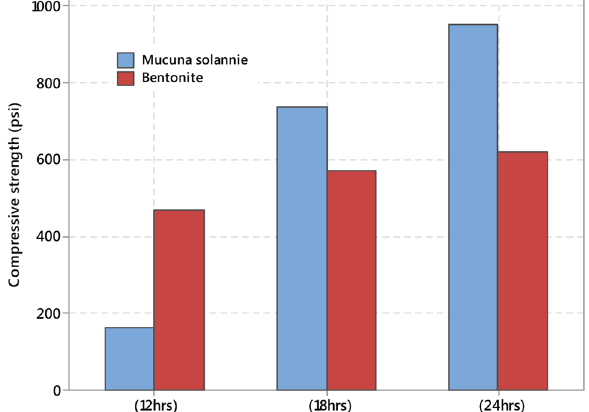
Fig. 12 Compressive strength of cement sheet formulated with Mucuna solannie and Bentonite extenders at 150 °F (65.6 °C) BHCT